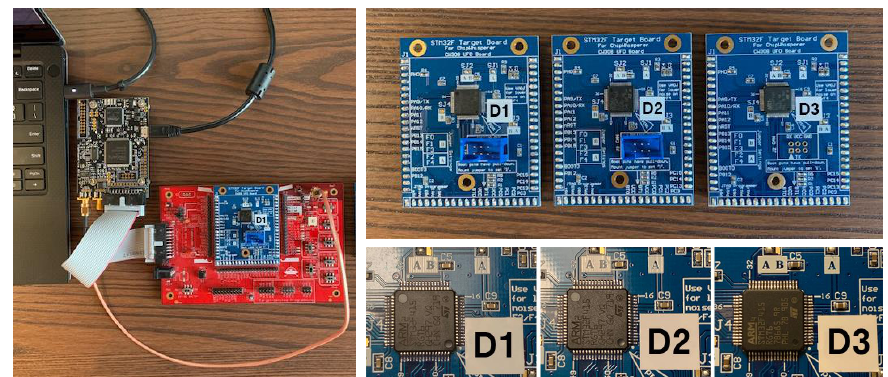
Figure 3: Equipment for trace acquisition and three boards used in the